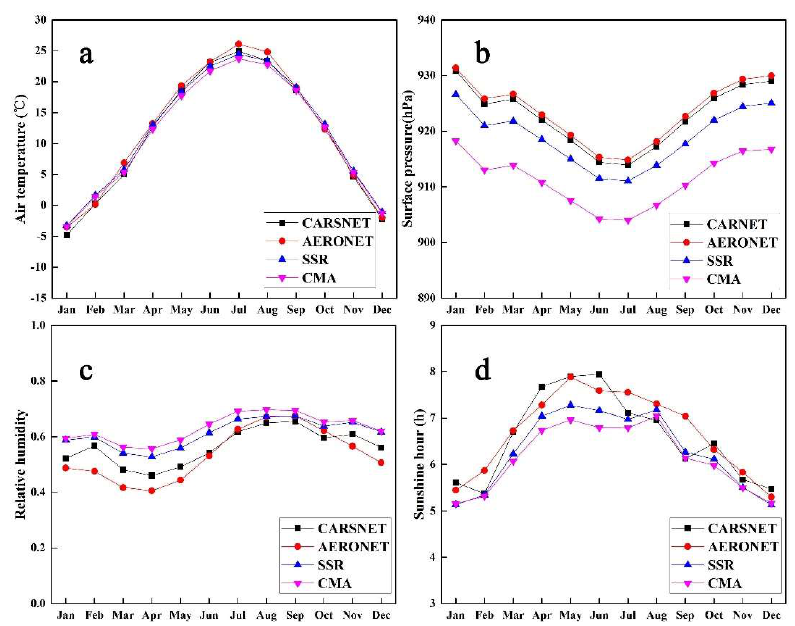
Figure 2. Monthly variations of metrological parameters for CARSNET, AERONET, SSR and CMA